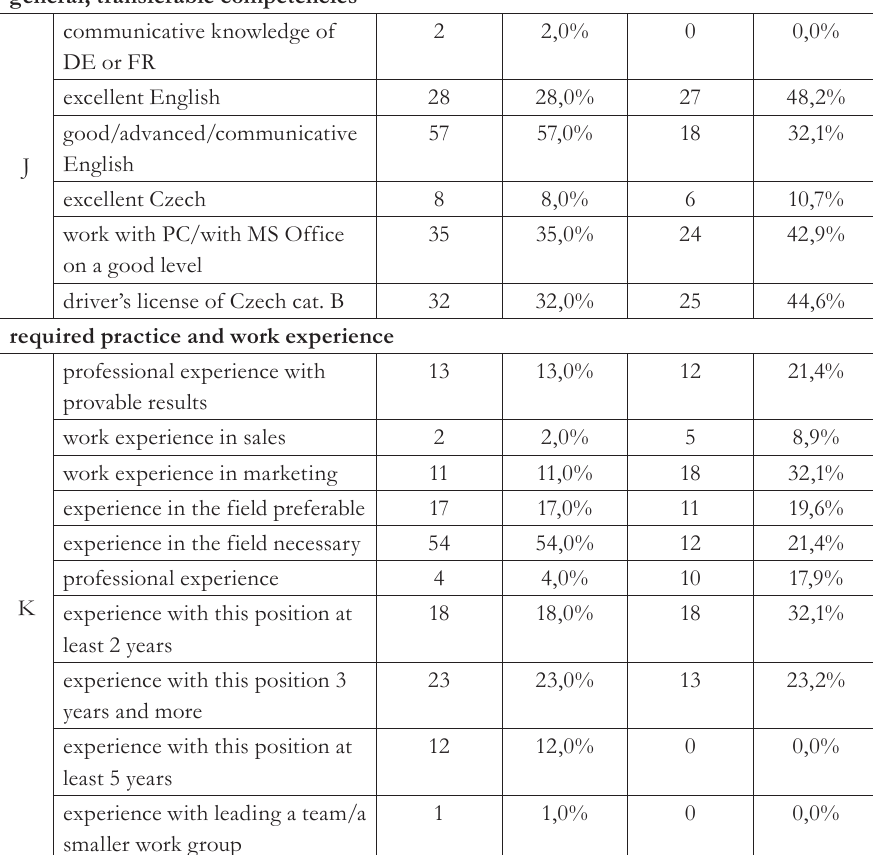
Table 4 is prepared for the set of requirements for professional knowledge and professional skills that are in Table 3 classified as the group H. It demonstrates the statistical verification proce - dure and the result of applying the independence test. A statistically significant difference in the distribution of requirements for technical knowledge and skills was confirmed for & = 0.05, as proven by calculations in Table